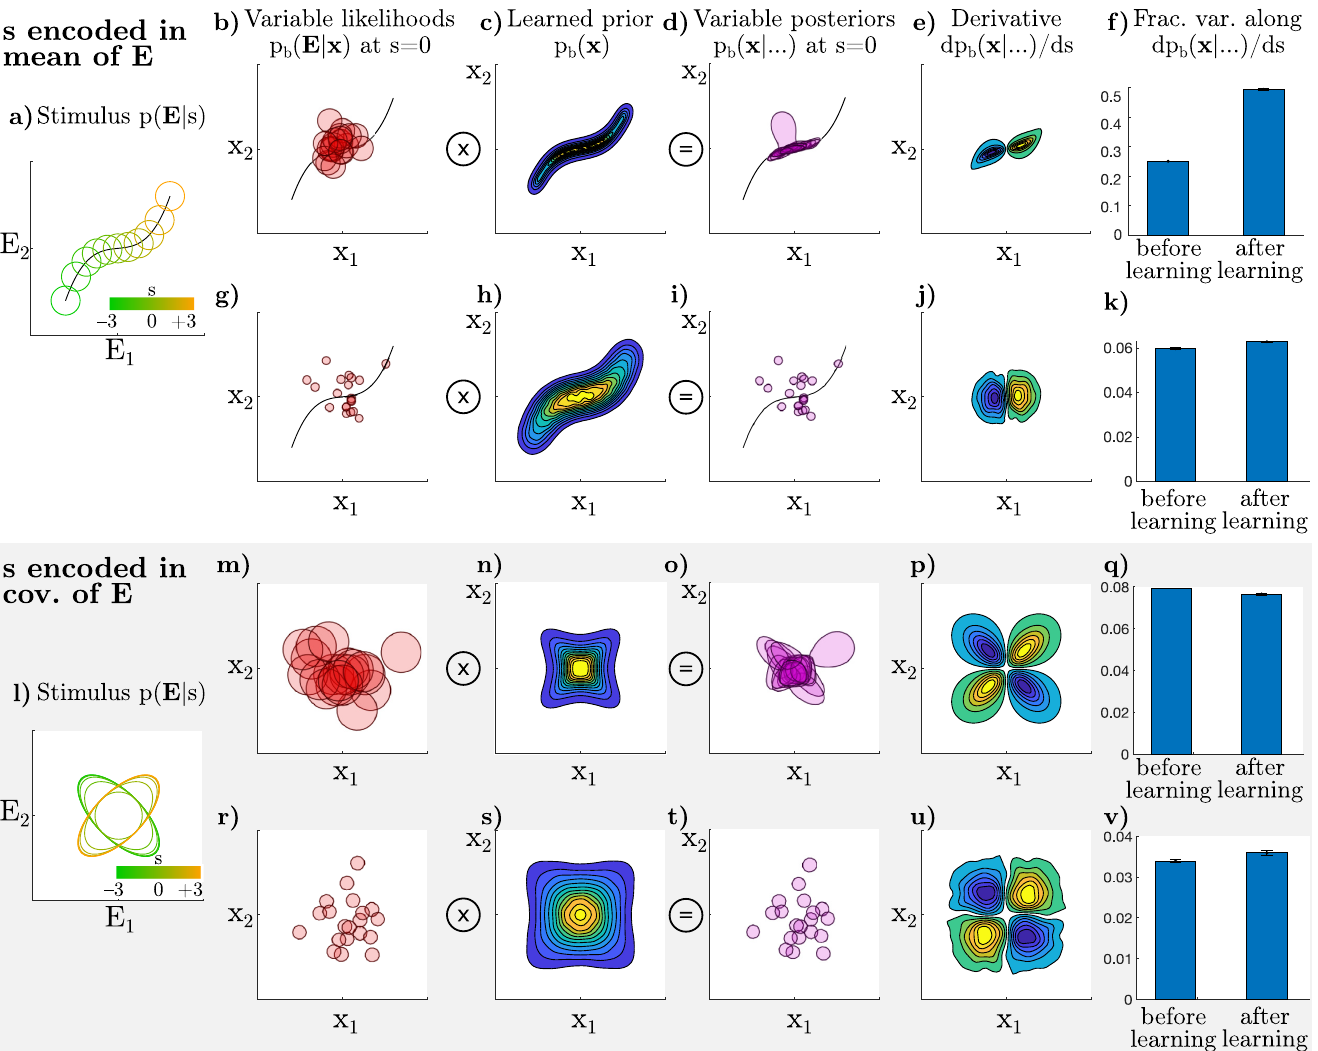
Fig 4. Numerical simulation of how variable likelihoods both determine and interact with the shape of the prior. Top two rows: mean of observations E depends on s as shown in panel (a). Bottom two rows (gray background): covariance of observations E depends on s as shown in panel (l). a) In this setup, observations are noisy, reflecting both internal and external noise. We set E to be two-dimensional, drawn from p e ( E | s ), a Gaussian whose mean depends on s (black curve). Ellipses indicate one standard deviation of p e ( E | s ). b) Now visualizing the space of latent variables, x , which we also set to be two-dimensional, such that the brain’s internal model assumes p b ( E | x ) is Gaussian, centered on x , with the shown variance. Each red circle shows a single contour of the likelihood, as a function of x , for a different E drawn from the p e ( E | s = 0) set of observations. c) After learning, the prior is extended along the curve that parameterizes the mean of x , such that the brain’s distribution on observations, p b ( E ) marginalized over x , approximates the true distribution on observations, p e ( E ) marginalized over s (Methods). d) Posteriors in the zero-signal or s = 0 case, given by the product of the likelihoods in (b) with the prior in (c). e) The direction in distribution-space corresponding to differential covariance in neural- space is the dp b /d s -direction, averaged over instances of noise. f) The fraction of variance in distribution-space (d) along the dp b /d s -direction. After learning, a larger fraction of the total variance is in the dp b /d s -direction, corresponding to increased differential correlations in neural space. g-k) Identical to (b) through (f), except that the brain’s internal model is more precise relative to the variations in observations E , modeled as smaller variance for p b ( E | x ).This has the effect of reducing the effect of learning a new prior in panel (k). l-v) Identical to (a) through (k), except that here, s parameterizes the covariance of observations E rather than their mean. This is analogous to, for example, an orientation-discrimination task with randomized phases, such that the average stimulus in pixel-space is identical for both categories. While panel (v) (precise model) shows a slight increase in variance in the dp b ( x | ... )/d s direction, consistent with (f) and (k), panel (q) (imprecise model) shows a slight decrease